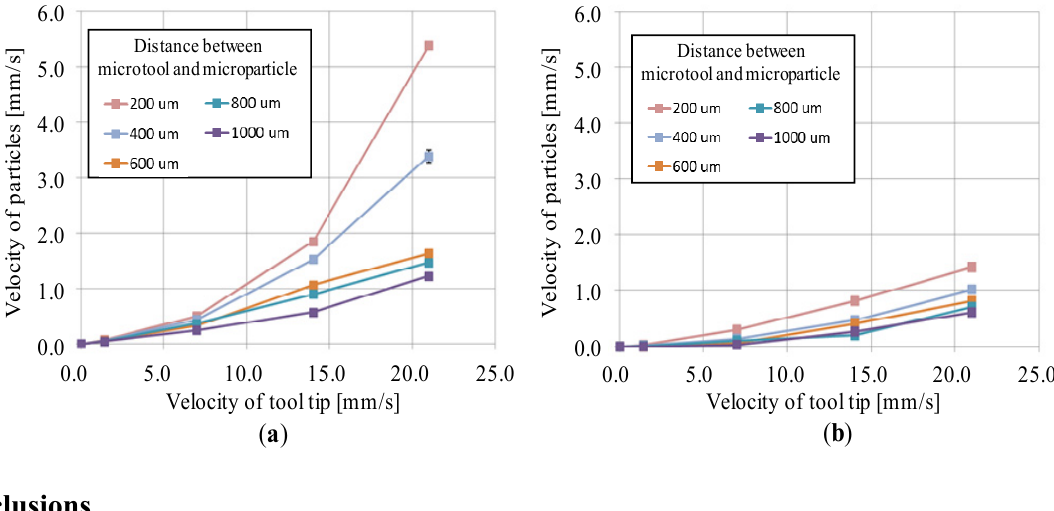
Figure 9. Measured oscillation velocity of the microparticle. ( a ) Previous microchannel and ( b ) surface-directed liquid